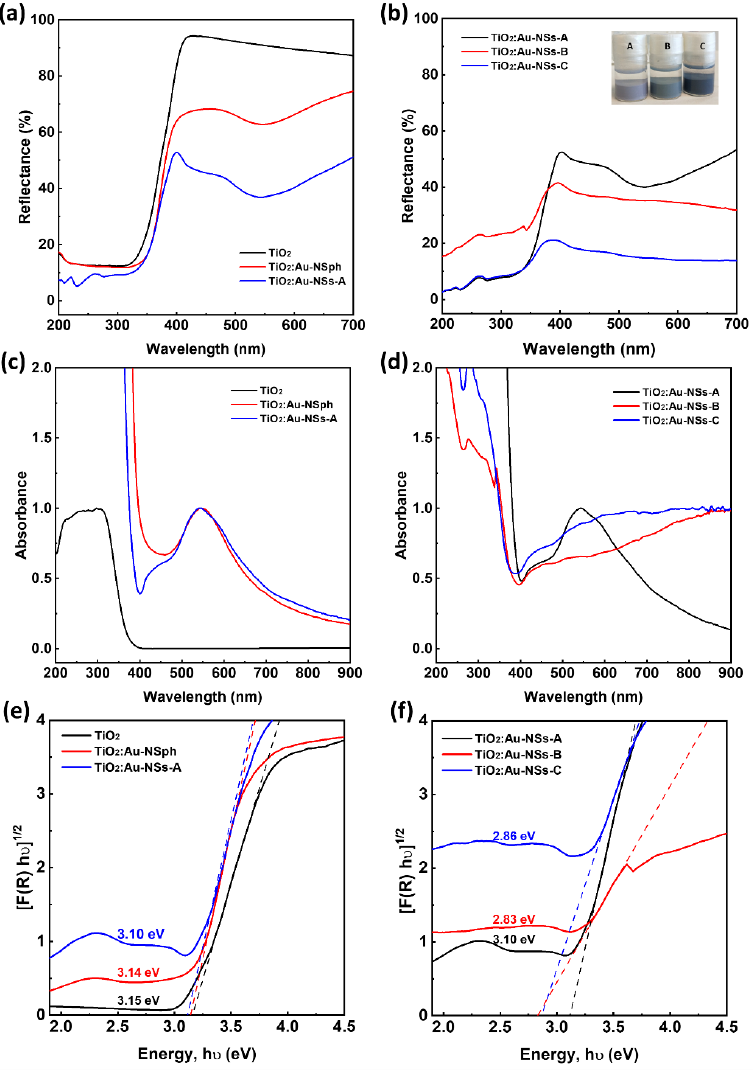
Figure 3. UV-Vis reflectance spectra ( a , b ) and UV-Vis absorption spectra ( c , d ) of the nanoparticles in the different synthesis steps ( a , c ) and nanoparticles with different Au NS sizes ( b , d ). Estimation of the bandgap for nanoparticles at different steps of the synthesis ( e ) and nanoparticles with different Au-NS sizes ( f ). (The bandgap is taken as the extrapolation of the linear part at [F(R)h ʋ ] 1/2 = 0).